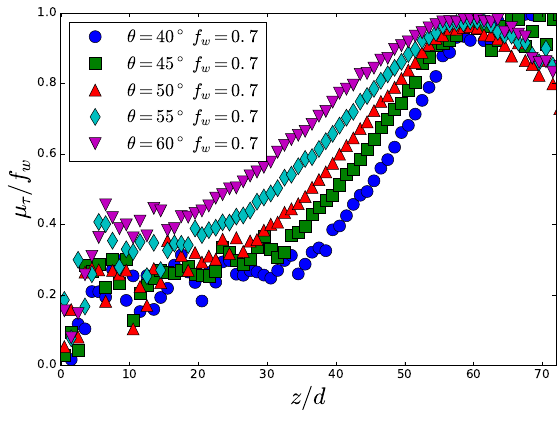
Figure 4. For a given system, the relation between the e ff ective sidewall friction coe ffi cient µ τ and the Froude number at side- walls is unique (a). This is true even at small Froude numbers